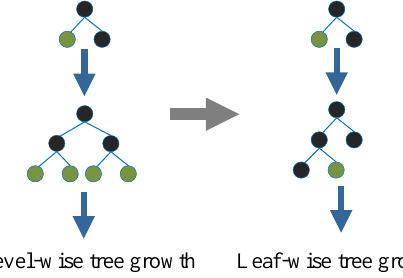
Figure 6. Levelwise and leafwise tree